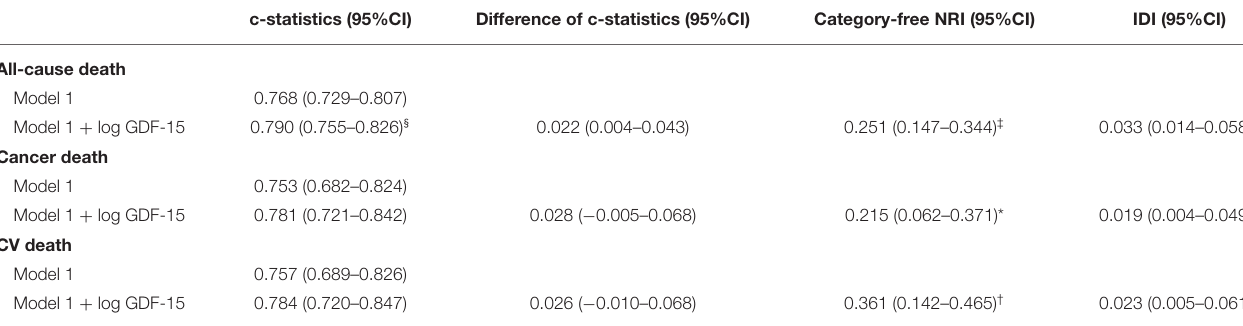
TABLE 3 | Change in risk-predictive metrics by incorporating prognostic biomarkers to the base